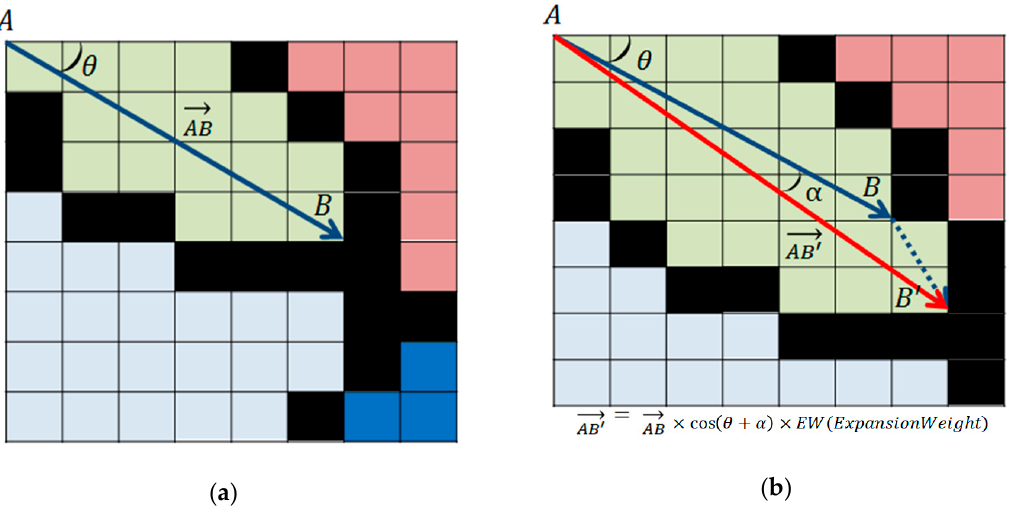
Figure 7. Example of cell vector expansion—( a ) cell vector; ( b ) cell vector expansion.